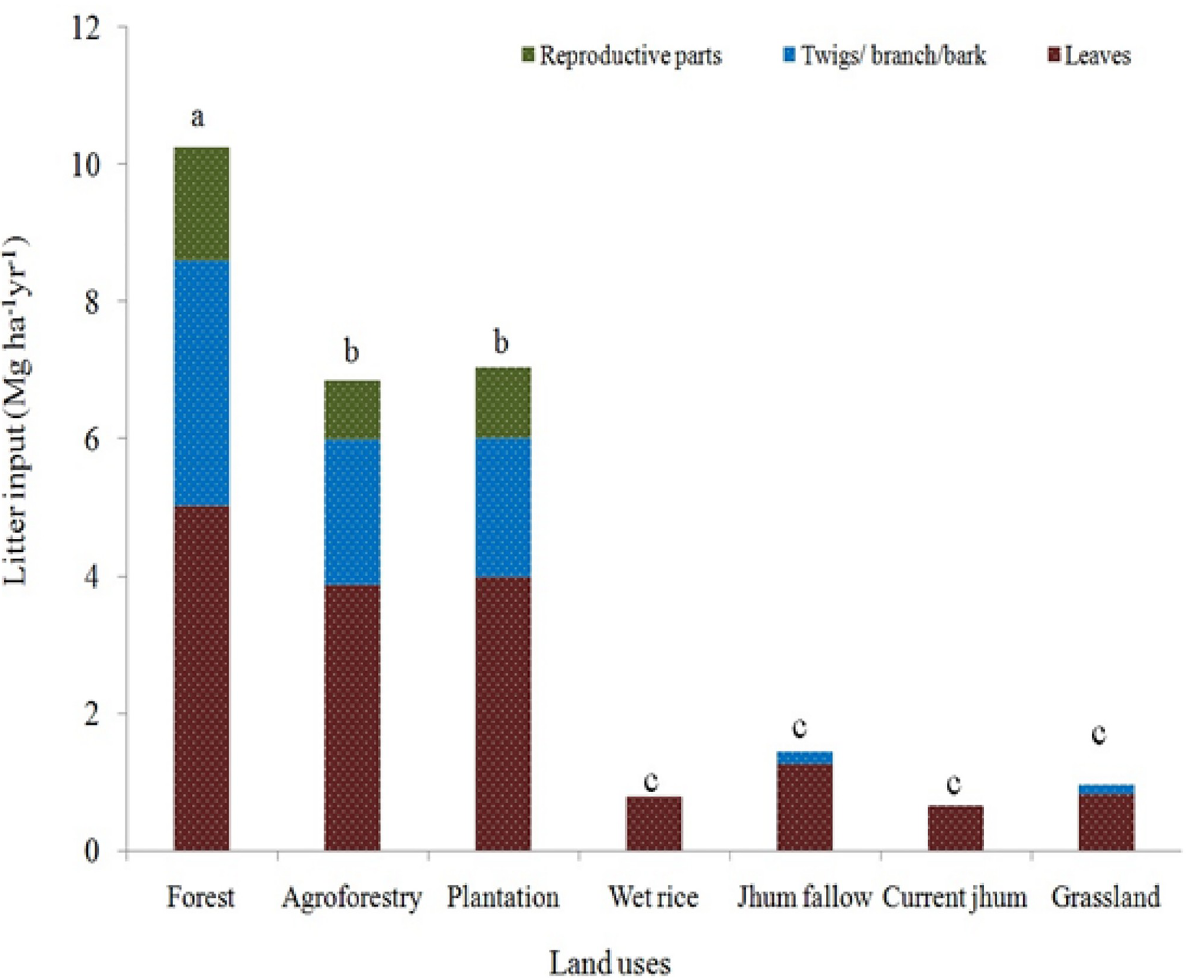
Fig 5. Litter inputs in different land use systems. (Different letters a, b, c indicate significant difference (p < 0.05) between the different land use types under study).